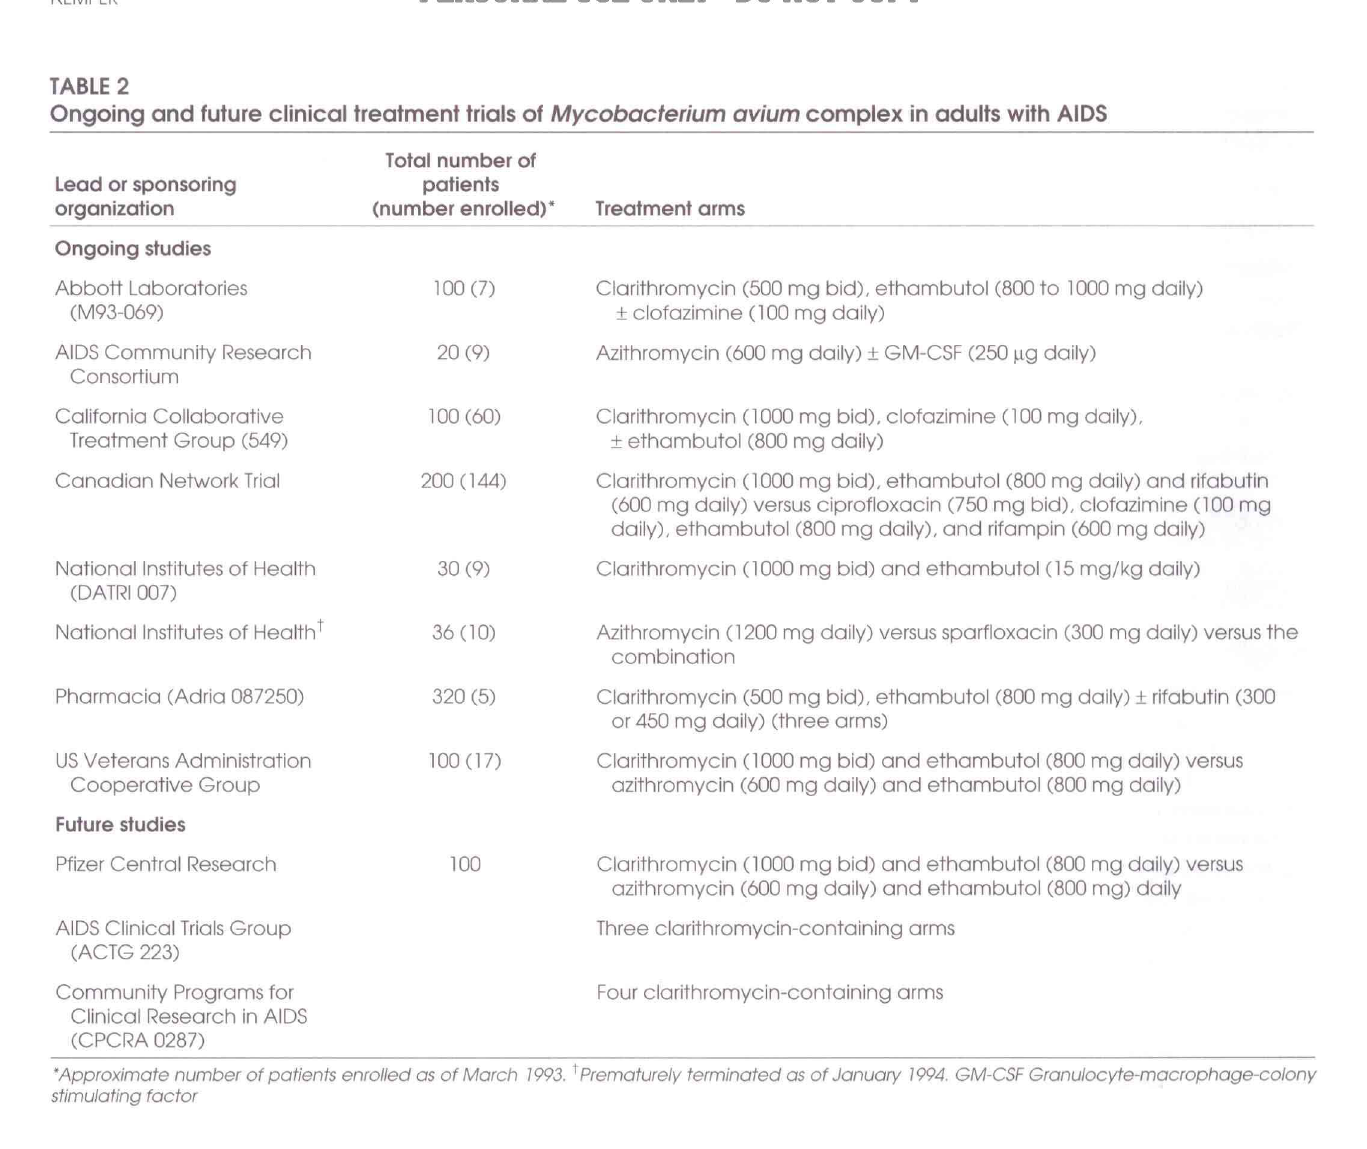
Ongoing and future clinical treatment trials of Mycobacterium avium complex in adults with AIDS Lead or sponsoring